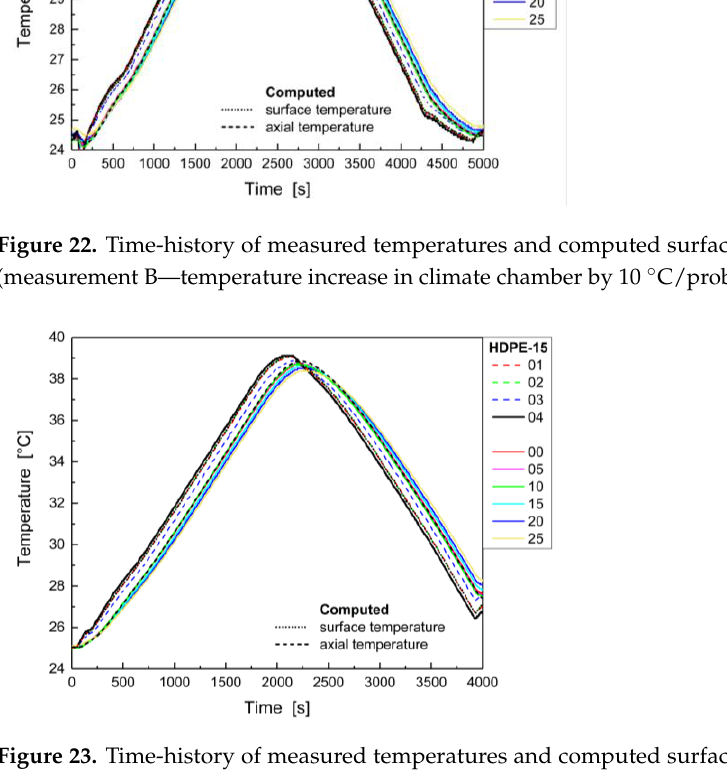
Figure 24. Time-history of measured temperatures and computed surface and axial temperatures (measurement B — temperature increase in climate chamber by 25 °C/probe 2). For the practical verification of the probe, we carried out a pilot installation in the premises of the University of Žilina in the vicinity of other experimental installations in the field of meteorology. The probe contains nine pieces of DS18B20 thermometers spaced with 0.1 m grid. The installation was completed at the end of October 2021. The imple- mentation is as follows: Sensor 9 is placed 0.1 m above the road surface, Sensor 8 is placed on the road surface, and Sensors 7 – 1 are placed 0.1 m to 0.7 m below the road surface. Figure 25 shows a graph of the temperature profile measurements from the start of the measurements in October 2021 to December 2021. Sensor 9 varies the most with respect to direct weather exposure at 0.1 m above the road surface. The effect of ambient temper- ature on the remaining sensors depends on their location below the road surface.